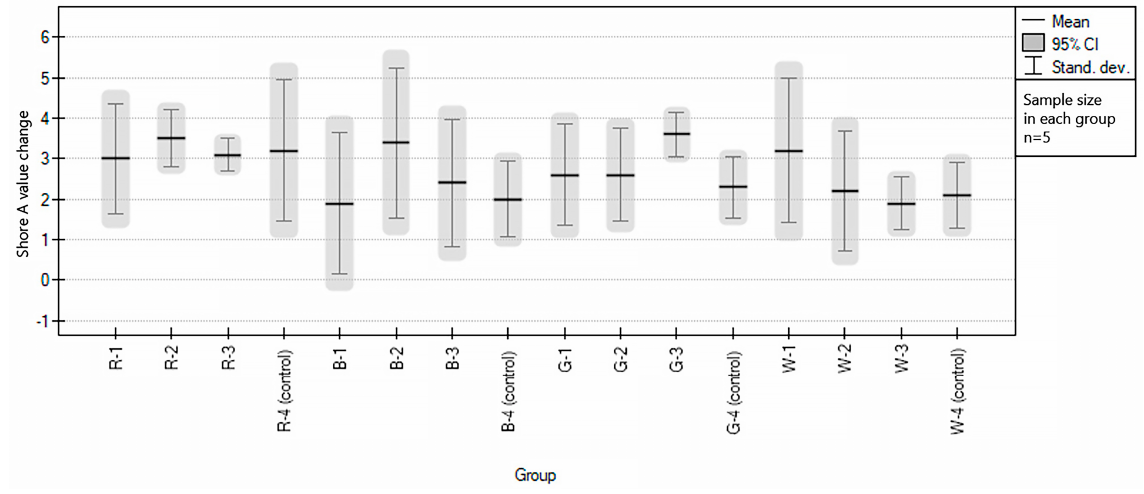
Figure 6. Graphical representation of the results of statistical testing of the hardness of EVA samples under the influence of sports drinks, divided into groups. under the influence of sports drinks, divided into